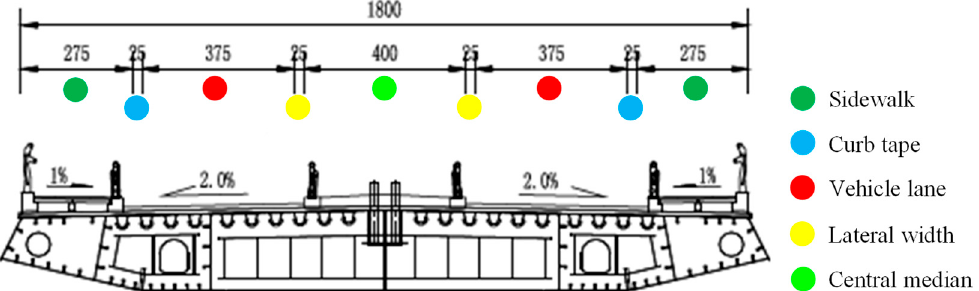
Figure 7. Integral standard cross-sectional arrangement (unit: